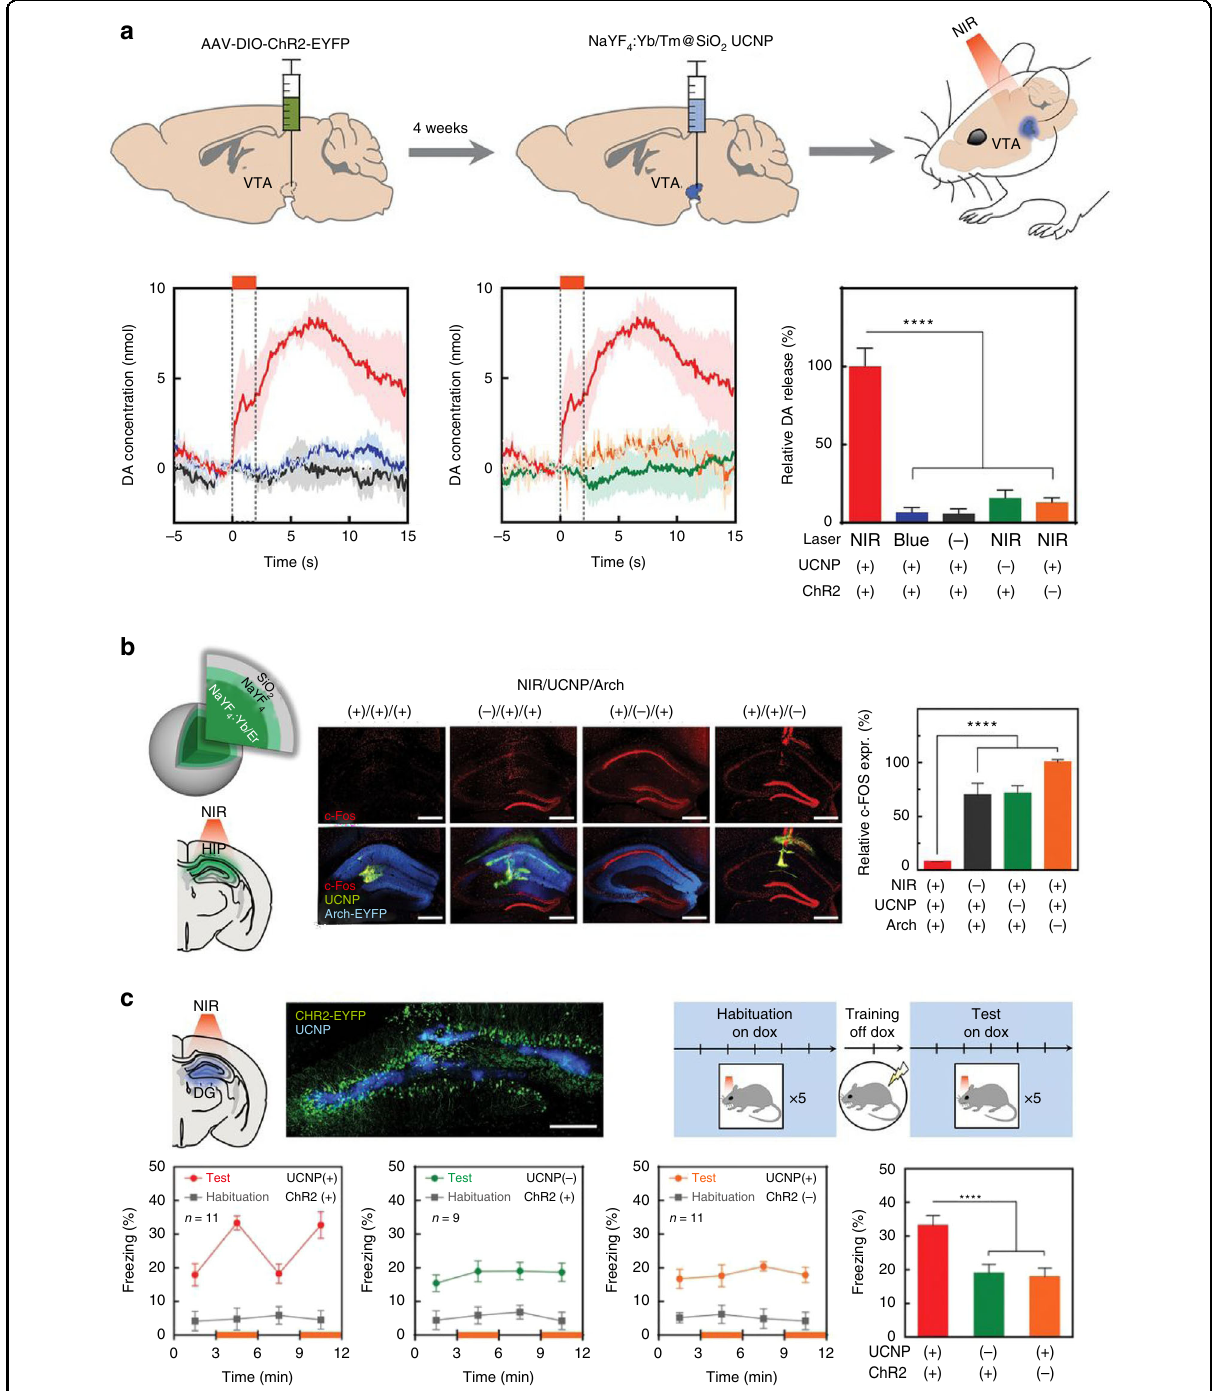
Fig. 11 NIR deep-brain stimulation through UCNPs-mediated optogenetics. a Transcranial NIR stimulation of VTA dopamine neurons. In the presence of both UCNPs and ChR2, signi fi cant release of dopamine can be detected under the stimulation of NIR. b Transcranial NIR inhibition of neural activity to silence seizure. c Transcranial NIR stimulation of hippocampal engram for memory recall. Reprinted with permission from ref. 103